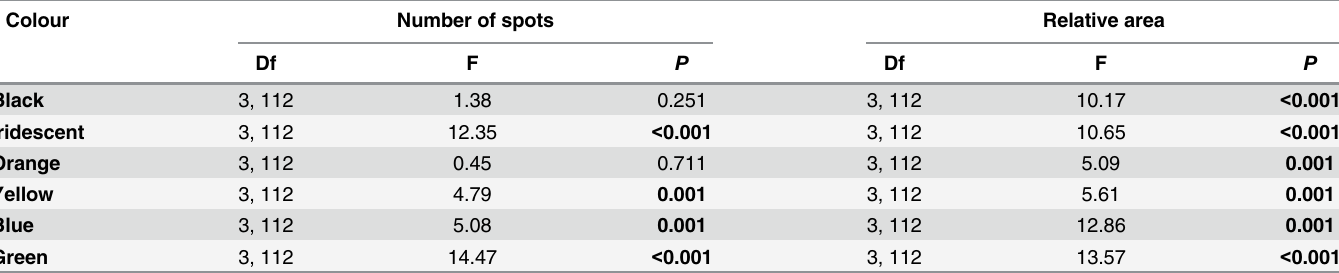
Table 3. Color variation in introduced populations of Poecilia reticulata . Results from ANOVAs examining variation across sites in the number and rela- tive area of colour spots in introduced populations of P . reticulat a from Panama. The analysis was based on 30 individuals per population. Values in bold rep- resent statistically significant differences.